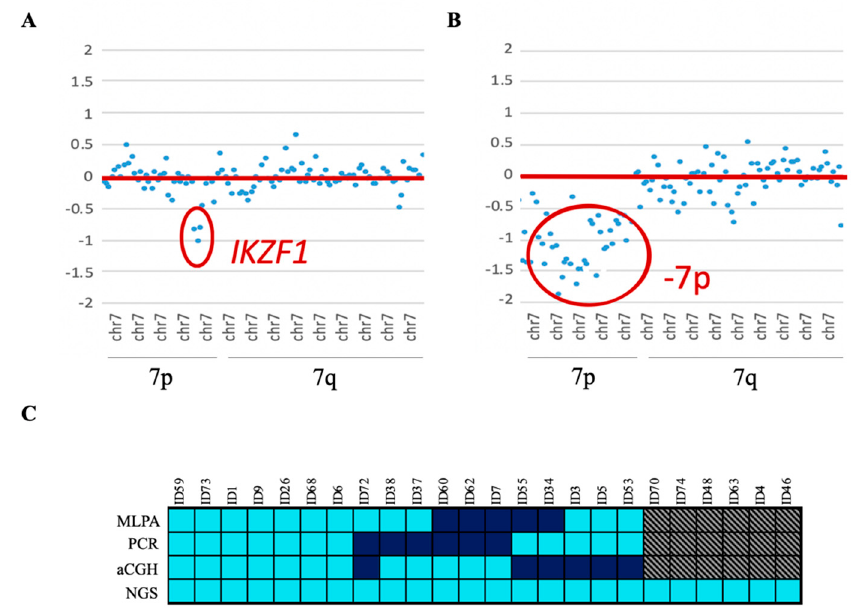
Figure 3. IKZF1 loss. ( A ) Dot plot of CNV representation, showing IKZF1 gene loss. ( B ) Dot plot of CNV representation, showing loss of 7p, which includes the IKZF1 gene. The x-axis represents the chromosome regions included in the custom NGS panel, in increasing order from chromosome 1 to X. The y-axis shows the log 2 ratios. The red lines indicate the reference, and the chromosomal regions above or below the reference are those inside the red circles, indicating the respective gain or loss of that region. ( C ) IKZF1 loss detected by NGS compared with the results obtained by conventional multiplex ligation-dependent probe amplification (MLPA), PCR, and aCGH techniques. Turquoise, detected; dark blue, not detected; grey, no information available. Each column represents one patient.